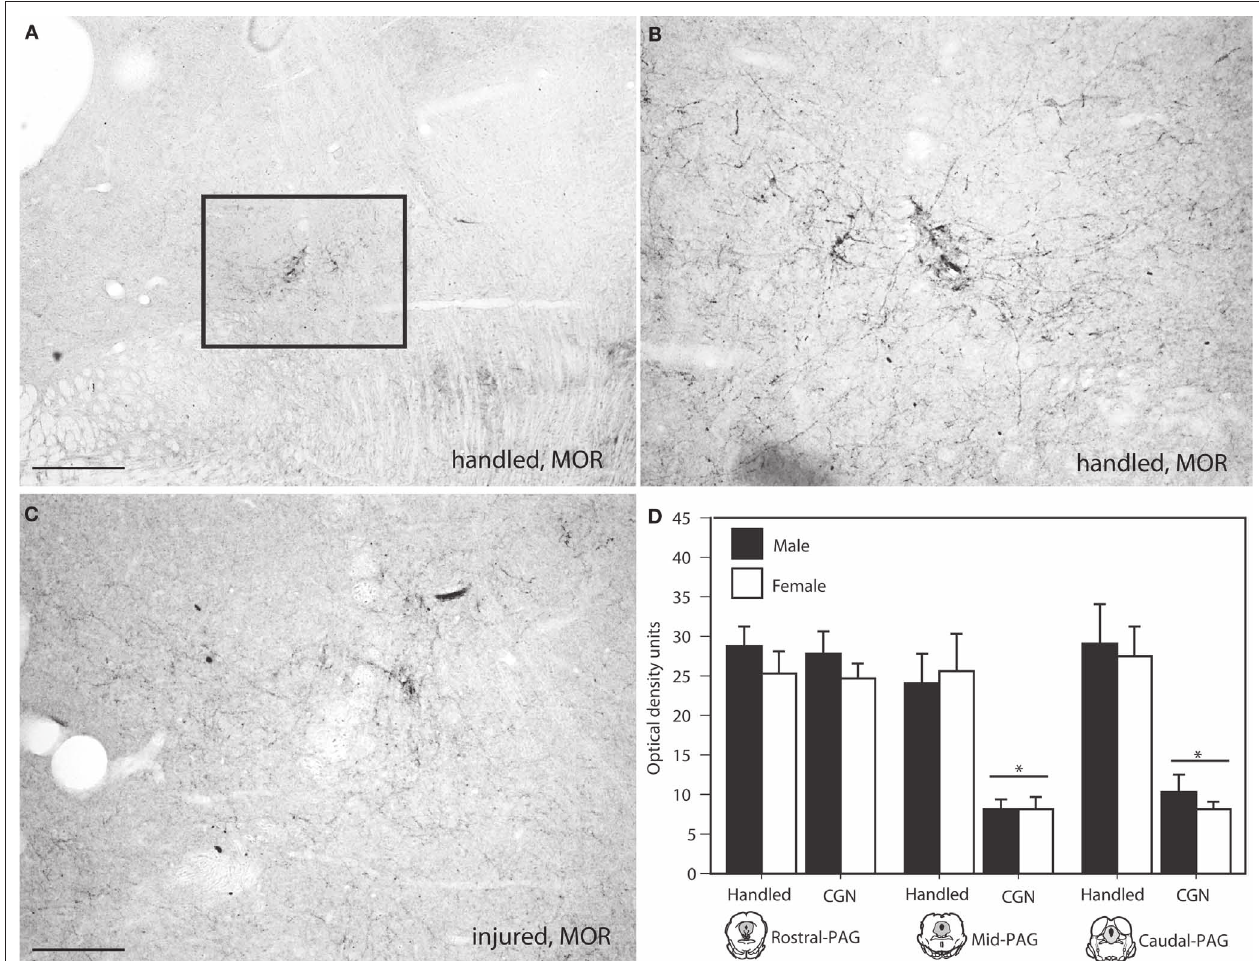
FIGURE 6 | Photomicrograph depicting representative examples of MOR-ir in the PAGl/vl in adult rats following neonatal treatment. (A) handled, 4 × , (B) handled, 10 × , (C) 1% carrageenan, 10 × . (D) At mid and caudal levels of PAG,